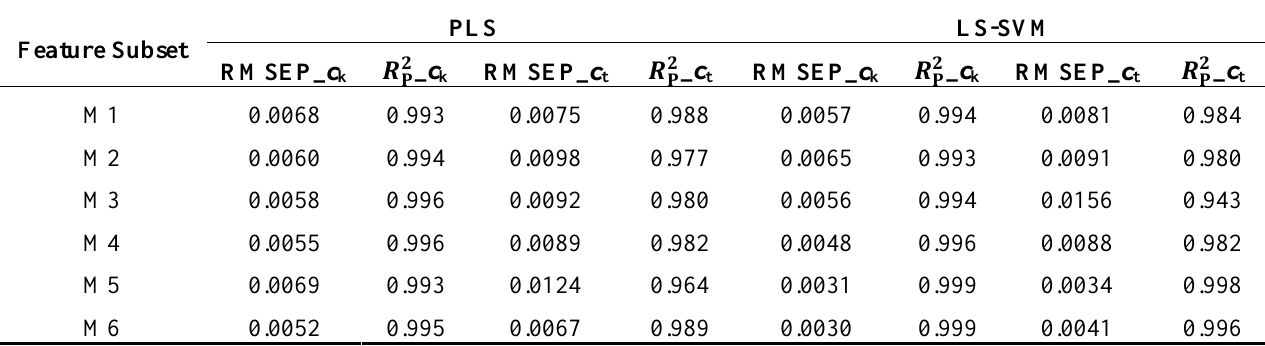
Table 3. The performance of the partial least square (PLS) model and the least squares support vector machines (LS-SVM)